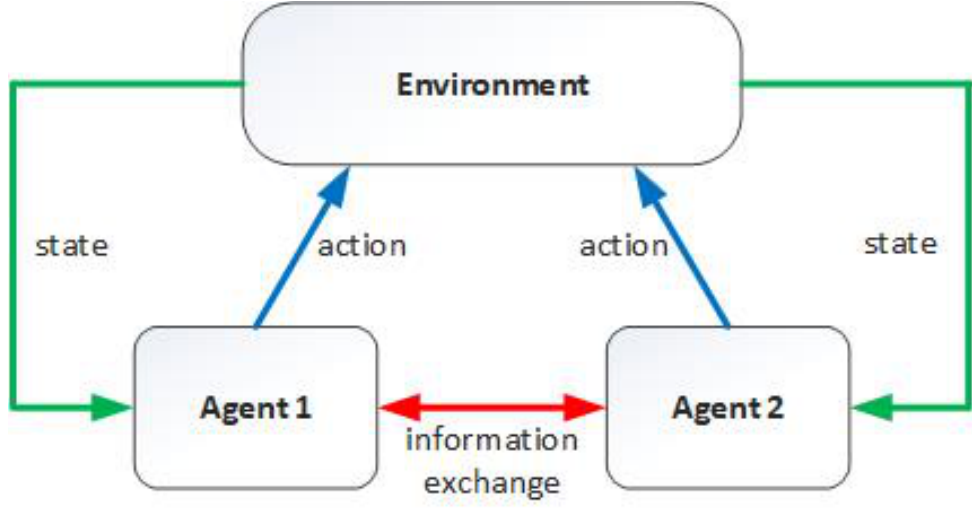
Figure 2. Multi-agent RL assisted mobile edge